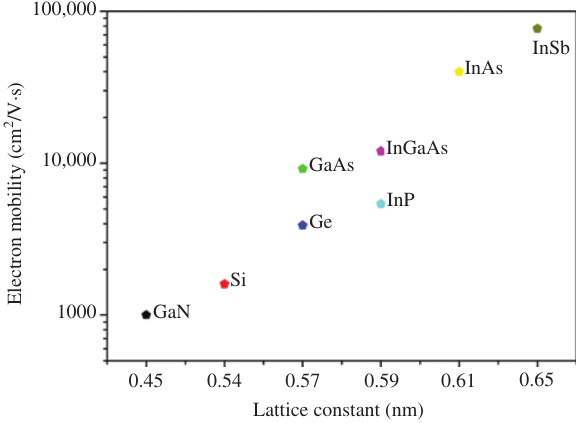
Figure 3: The highest electron mobility at room temperature in inversion layers and quantum wells for various semiconductors is shown as a function of actual semiconductor lattice constant [15].